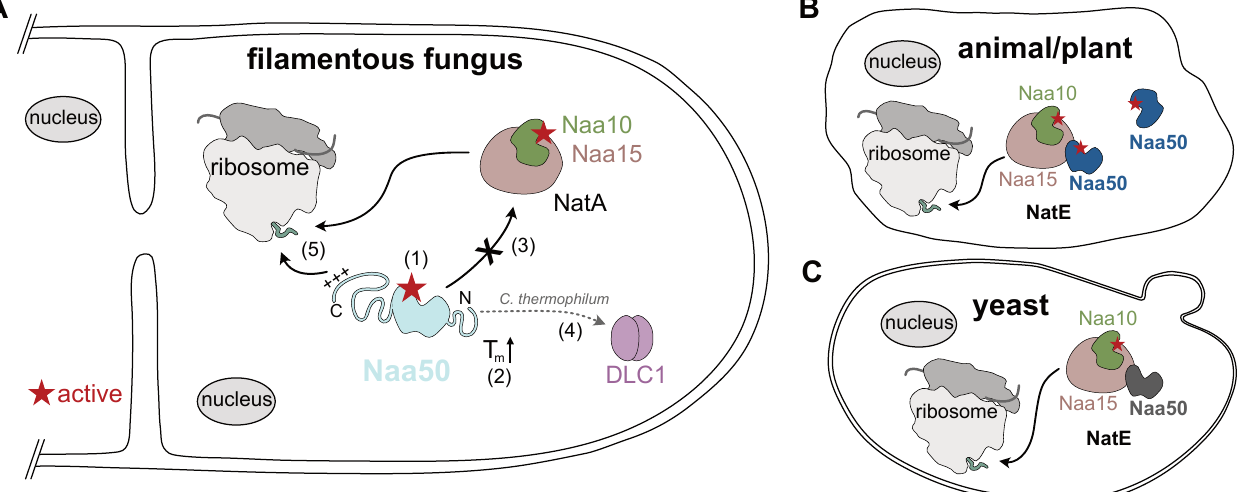
Figure 11. Diversity of Naa50 in different organisms. ( A ) Naa50 (teal) from filamentous fungi contains significant N- and C-terminal extensions and shows N-terminal acetylation activity towards typical NatC/E/F-type substrates (1). The N-terminus increases its thermostability (2). It does not interact with NatA, and therefore a NatE complex is not formed in filamentous fungi (3). In C. thermophilum , a binding motif within the N-terminus allows for interaction with DLC1 (4). Positive patches within the C-terminus enable ribosome binding without NatA (5). ( B ) Naa50 in animals and plants (blue) is active and can form a NatE complex with NatA. ( C ) Yeast Naa50 (grey) is inactive due to missing catalytic residues. It forms a NatE complex and can bind to the ribosome as